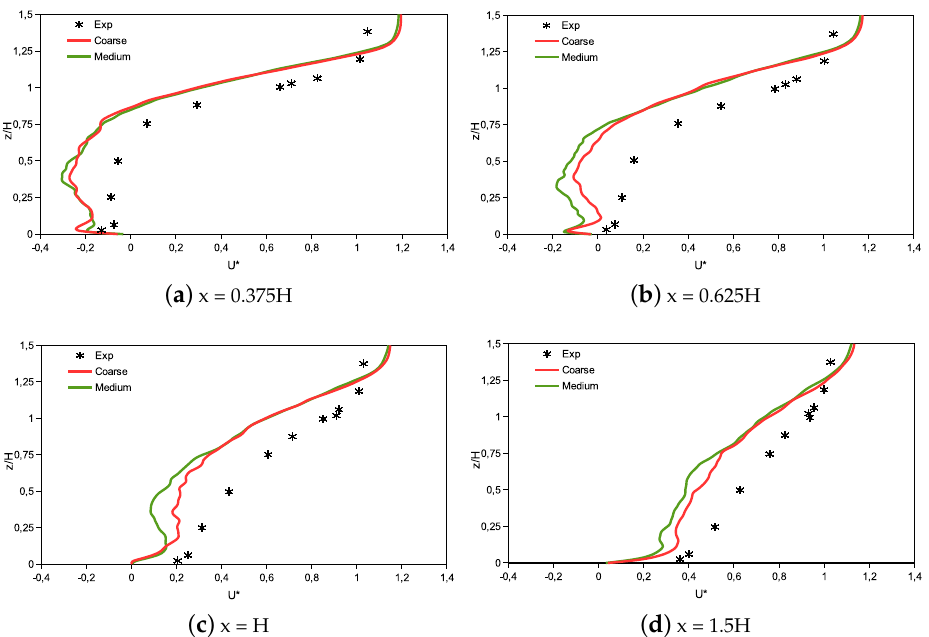
Figure 10. Comparisons of normalized streamwise velocity at different positions downstream of the building.